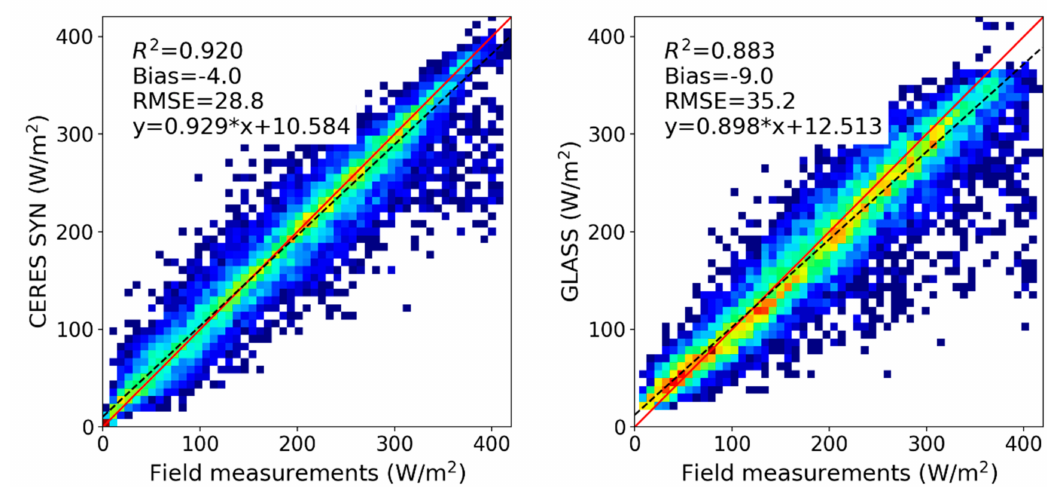
Figure 9. Validation results of the Clouds and the Earth’s Radiant Energy System (CERES) and Global LAnd Surface Satellite (GLASS) daily DSR product using the BSRN 2018 DSR